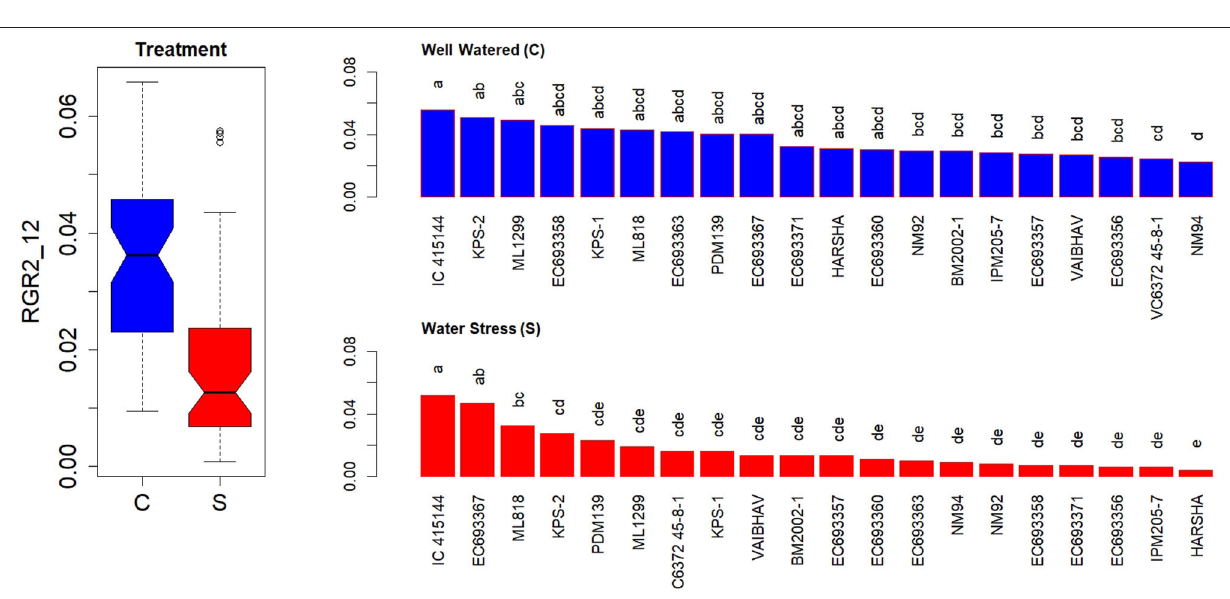
EMR in the NIR range of the spectrum. The results